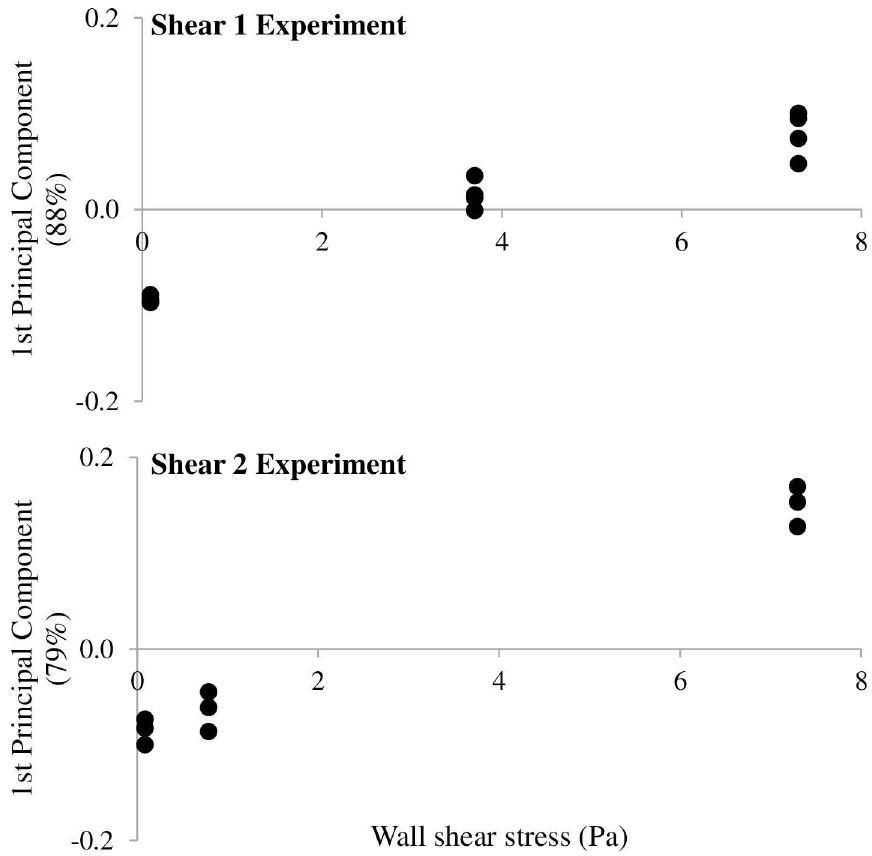
Fig 3. Results of the microbial community characterization for Phase 2, shear stress impact test. Attached bacterialcommunities on PP slides with wall shear stress tested for Shear 1 (A) and Shear 2 (B) experiments are presented. Each point ( ● ) corresponds to one slide. As mentioned in Table 2, four and three slides of PP were characterized per reactor for Shear 1 and Shear 2, respectively. One slide is missing (Shear 1, 0.09 Pa) becausethe DNA extraction did not succeed, hencethree replicates are represented on the plot. Y-axes are the first PrincipalComponent resultingfrom the PCA performed on each experiment. For Shear 1 and Shear 2, the first PrincipalComponentsums up 88% and 79% respectivelyof the total information that are containedin SSCP